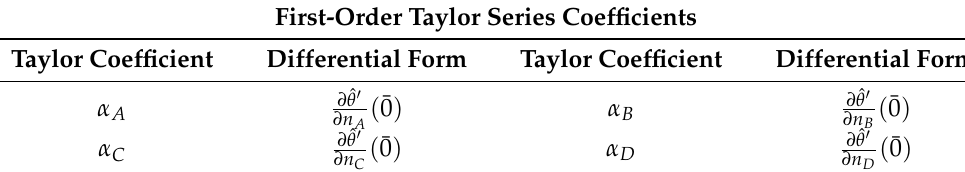
Table A1. First-order and second-order Taylor